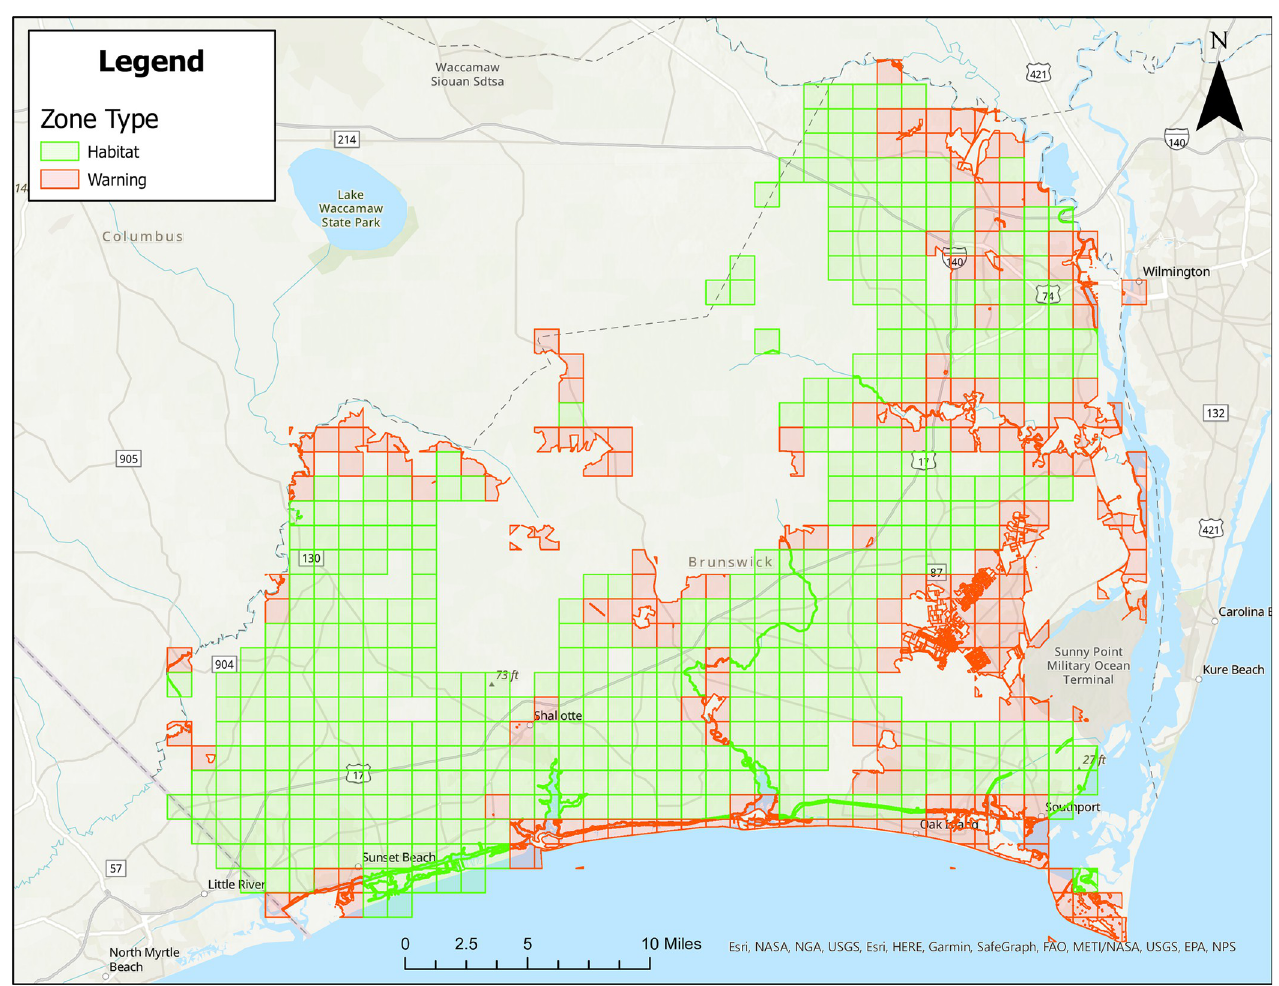
Fig 1. Areas in Brunswick County, North Carolina for treatment consideration classified as approved (green) or warning (red). Maps do not consider human population density. Source files for maps (NC OneMap: Address, county, rivers, water bodies provided as S2 and S3 Files. Written release agreements to authorize use of geospatial data found on the NC OneMap website are not required. https://www.nconemap.gov/pages/terms.